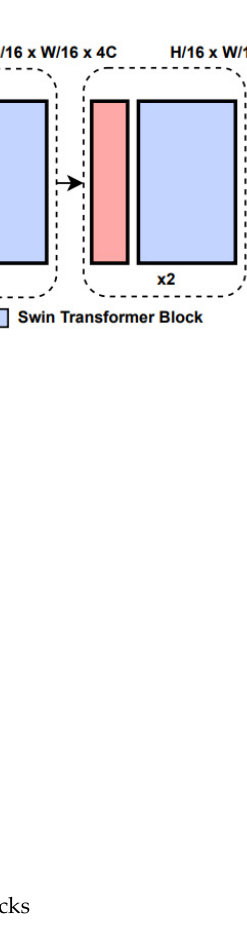
Figure 1. Structure diagram of Swin